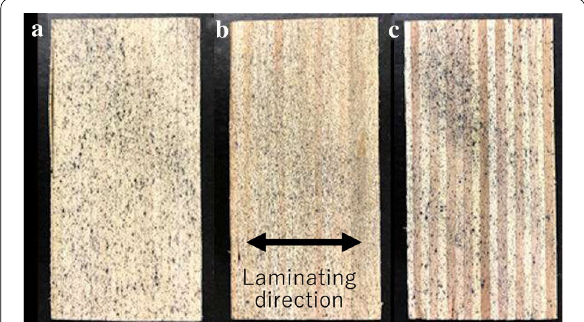
Fig. 3 Compression specimen: left: P-LVL, center: E-LVL, right: